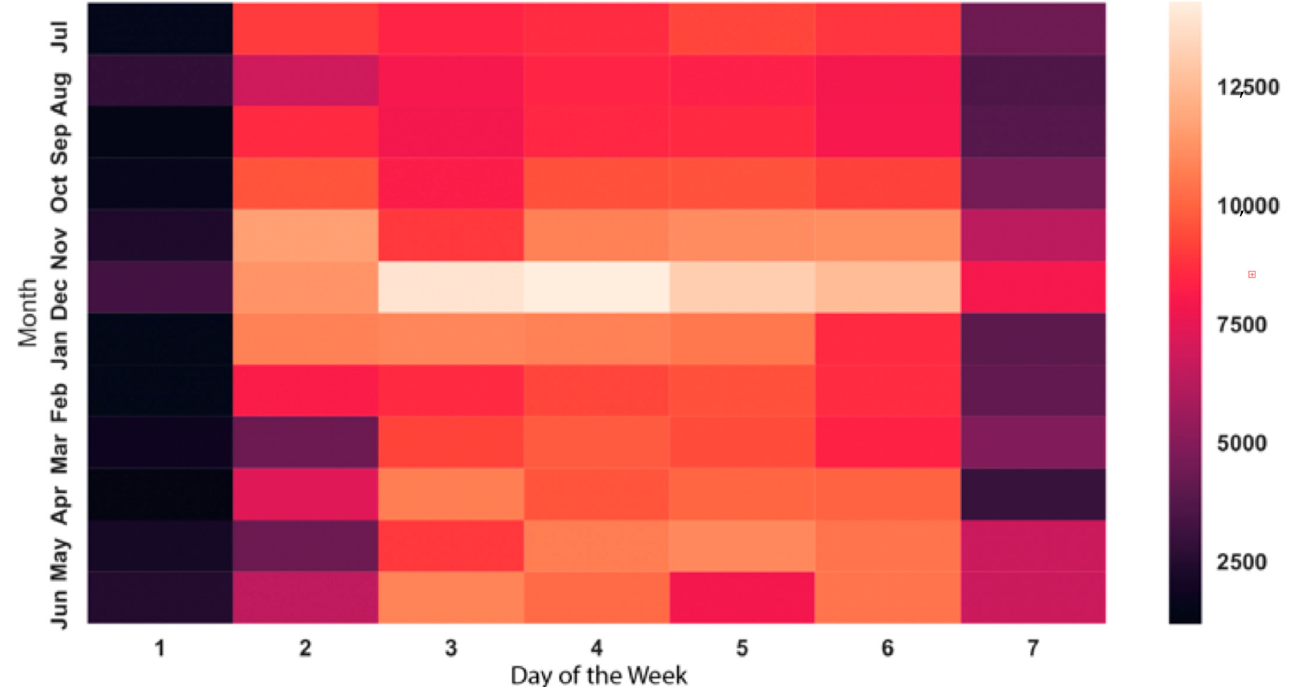
Figure 6. Number of lockers required per day depending on the weekday and month (Density 1.0).